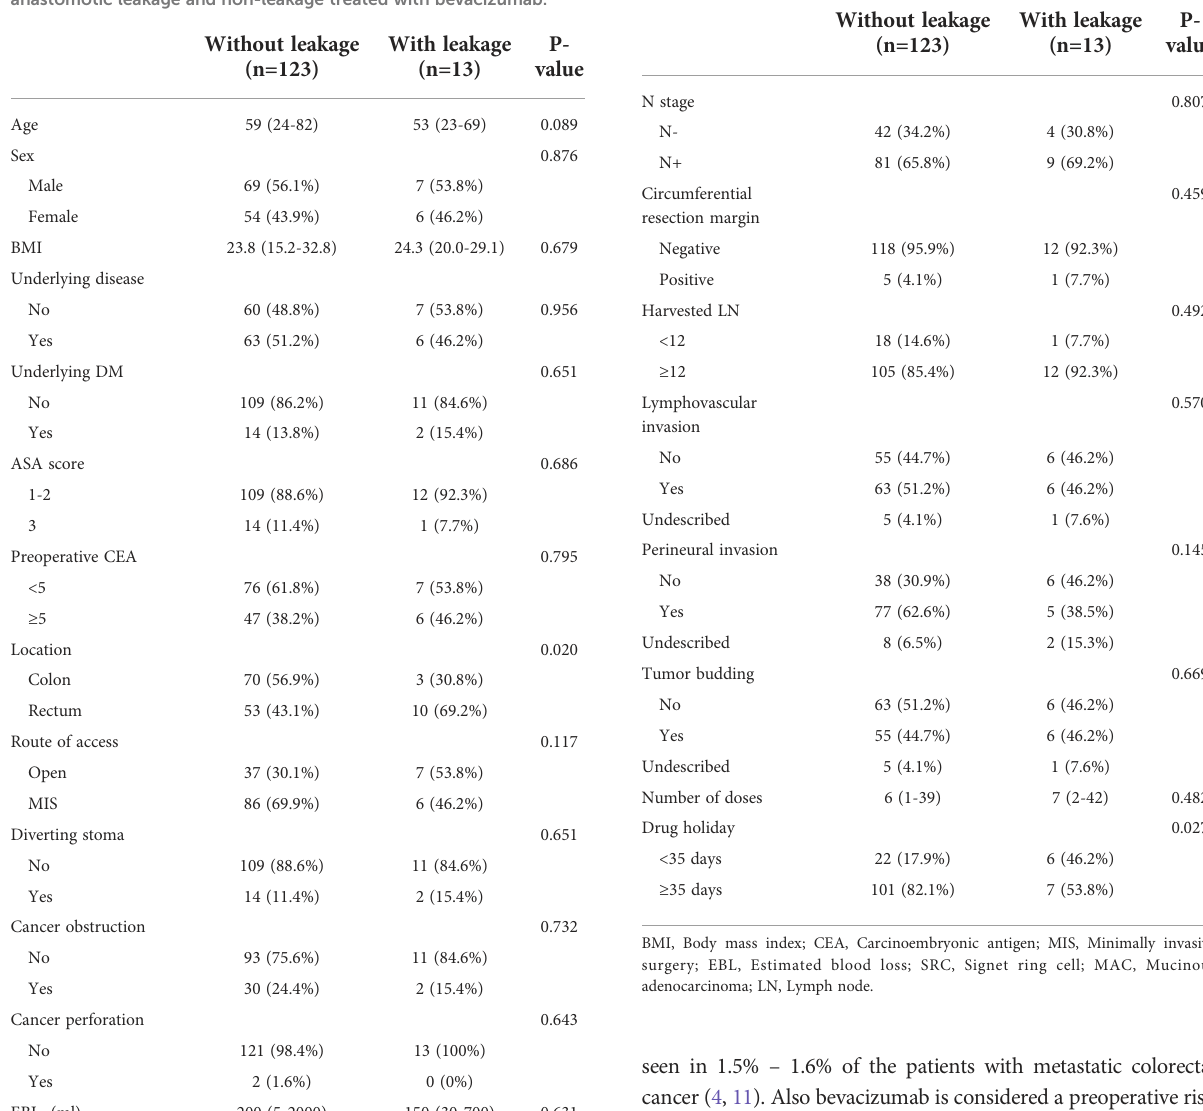
TABLE 2 Baseline clinicopathologic features of patients with anastomotic leakage and non-leakage treated with